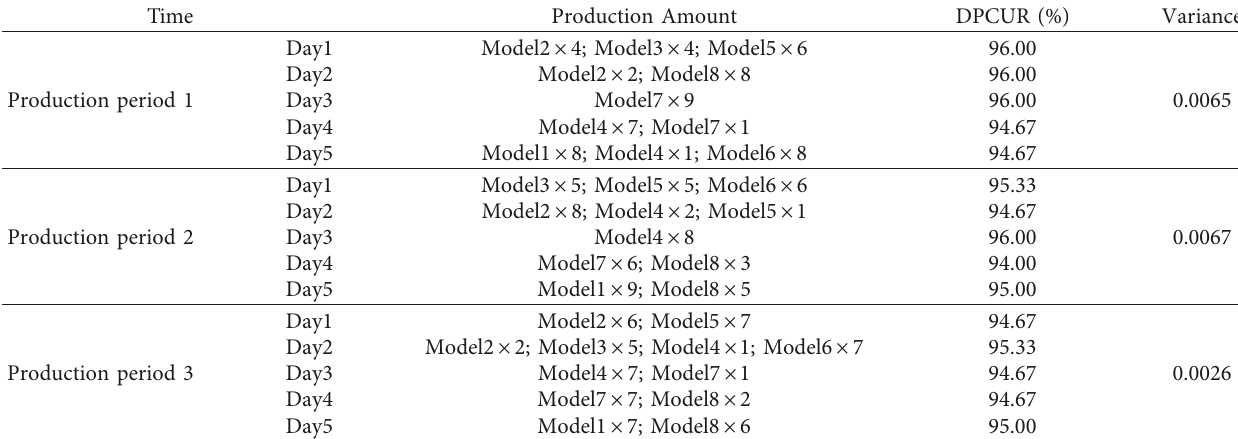
Table 6: Optimization results of random order of prefabricated